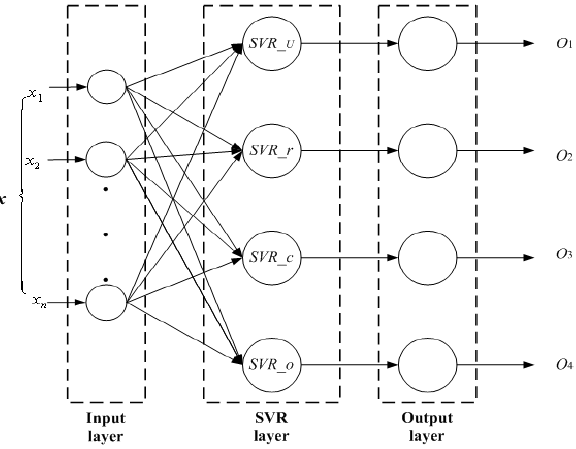
Figure 3. Structure of the proposed BSVR.